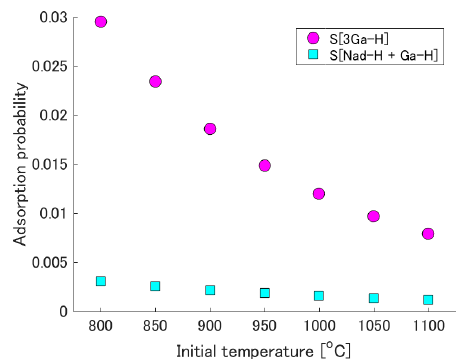
Figure 4. Initial temperature dependence of the adsorption probability at equilibrium.